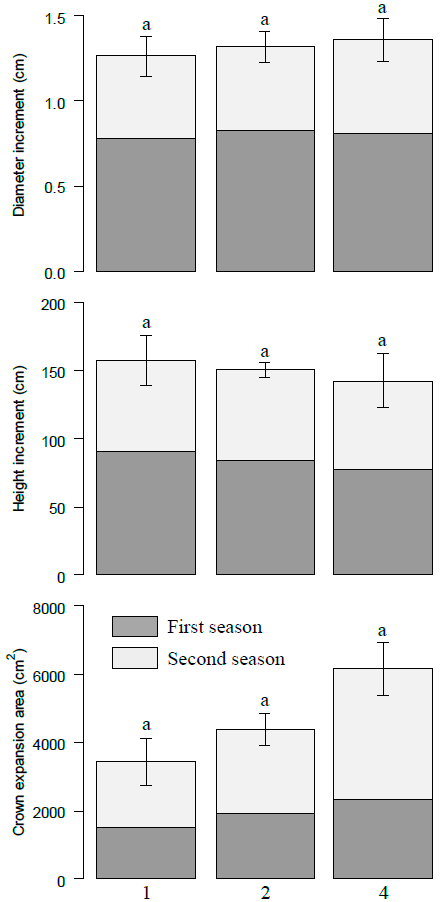
Figure 2. Total increments of diameter, height and crown projection area at different species richness levels on the pot level. The number 1, 2, and 4 represent monoculture, two species and four species mixtures, respectively. Bars represent means ± SE. Different letters indicate significant differences among different species richness levels, p <0.05.